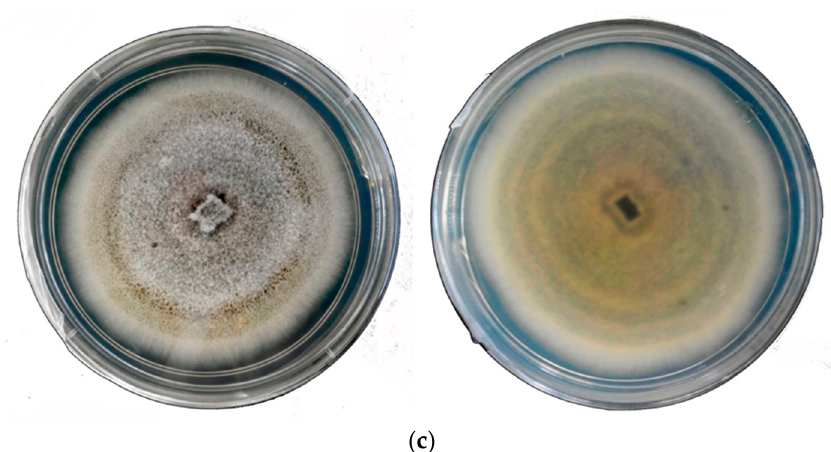
Figure 1. ( a ) Appearance of anthracnose on chili fruit: Dark and sunken necrotic tissues lesion with concentric rings of acervuli (measurement in cm); ( b ) presence of setae in acervulus (40 × ); ( c ) Colletotrichum truncatum (Syd.) E.J. Butler and Bisby.